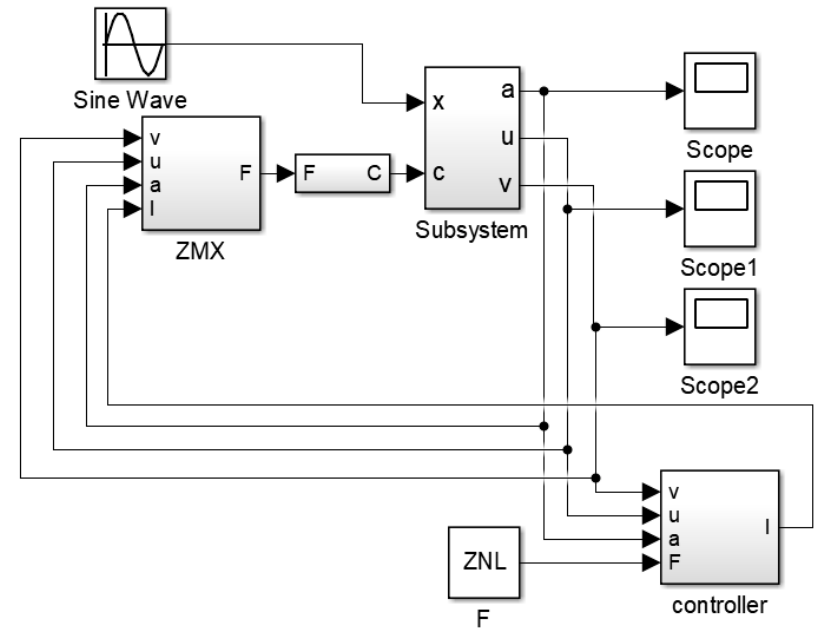
Figure 10. Simulation model of magnetorheological suspension.